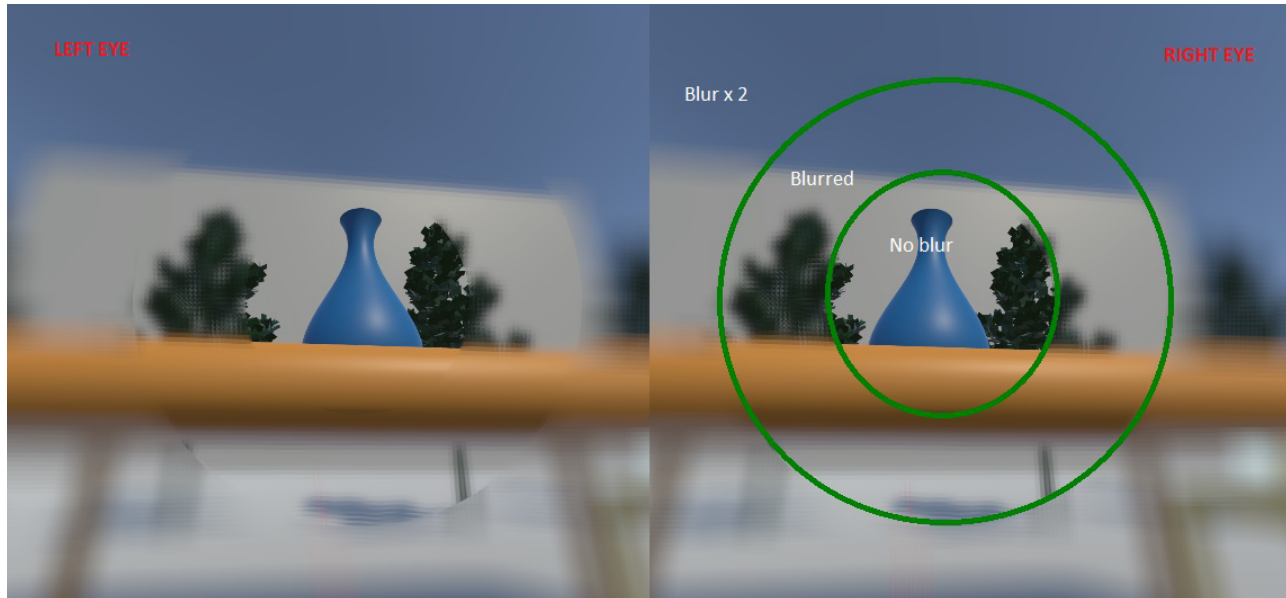
Figure 6. Stereoscopic view of the multi-region foveation output. The central region has no blur applied while the other two regions (highlighted in green for sake of visualization only) have different blurs applied to